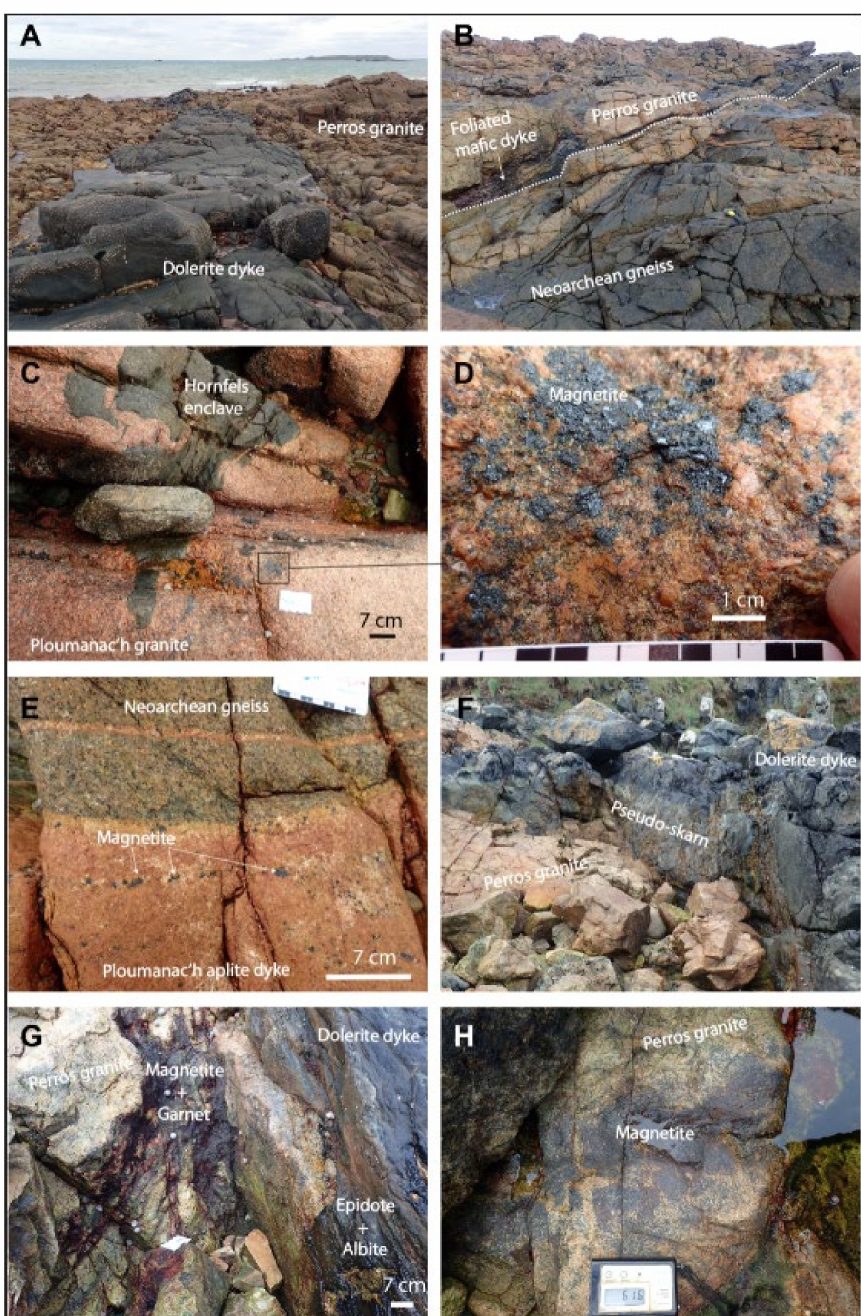
Figure 5. Selected images illustrating the relationships between the pseudo-skarn and the Carboniferous magmatism and associated late magmatic and hydrothermal fluids. ( A ) NE-SW-trending 3 m-thick mafic dyke crosscutting the Neoproterozoic Perros-Guirec granite. ( B ) Strongly deformed mafic dyke of the second generation injected within a low dipping reverse fault. Fault dip is to the west. ( C , D ) Disseminated magnetite within Ploumanac’h Carboniferous monzogranite, close to the border of the intrusion. ( E ) Disseminated magnetite within a Ploumanac’h aplite dyke crosscutting the Paleo-Proterozoic gneiss. ( F ) Pseudo-skarn (light green) at the contact between a first generation of dolerite dyke and the Neoproterozoic Perros-Guirec granite. ( G ) Close view of the pseudo-skarn along the contact between a dolerite dyke and Perros-Guirec granite. Numerous veins mainly composed of epidote+albite are located in the dolerite and numerous dissemination of mainly magnetite+garnet are located within the Perros-Guirec granite. ( H ) Example of massive magnetite disseminated within Perros-Guirec granite. Kappameter for scale with a magnetic susceptibility measurement of 616 × 10 − 3